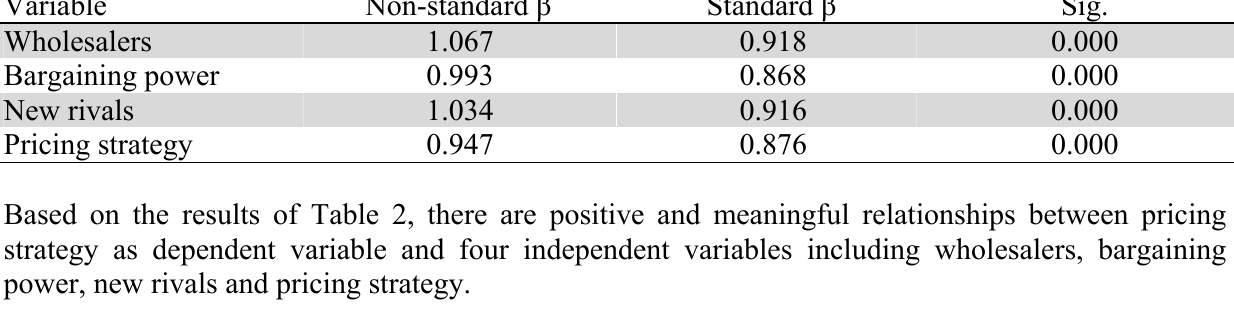
The summary of stepwise regression analysis